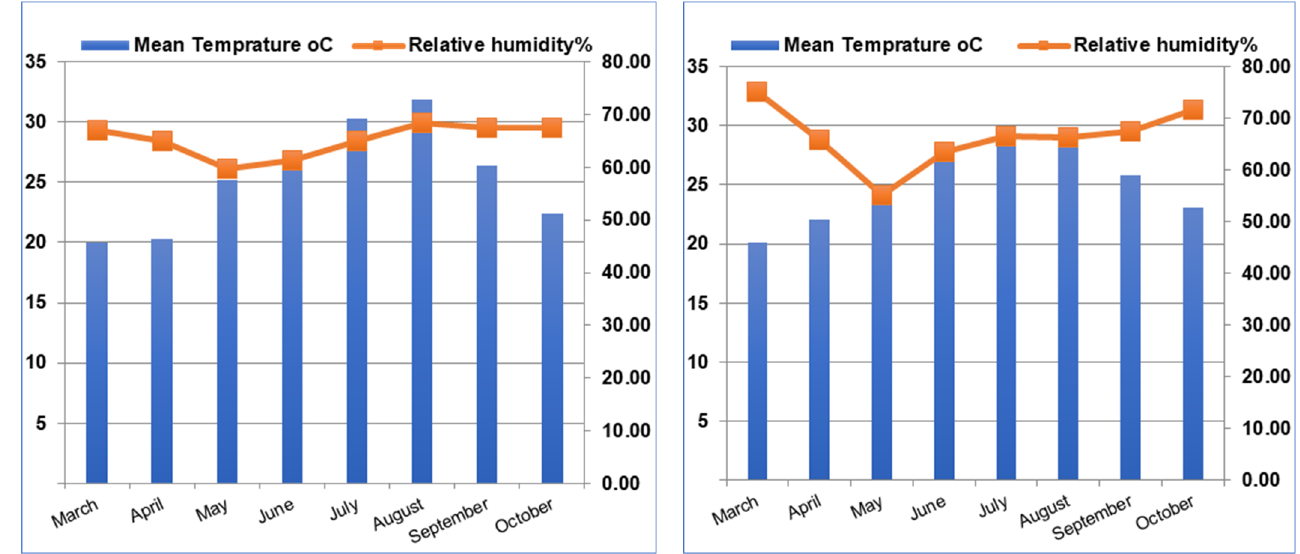
Figure 1. Average temperature and relative humidity of experimental site throughout 2019 and 2020 seasons.